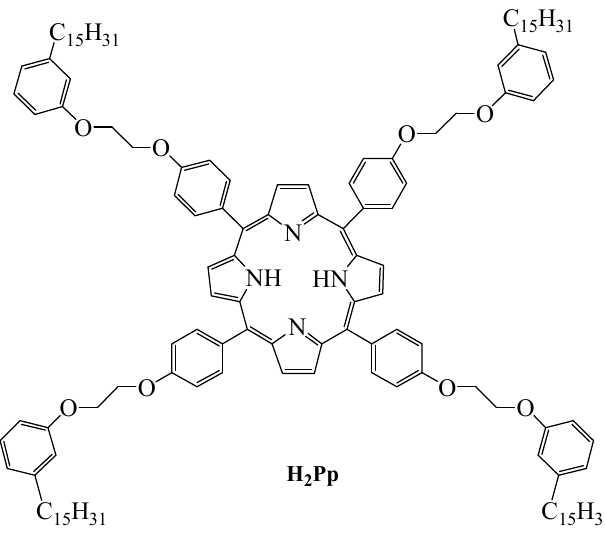
Figure 2. Structure of the lipophilic porphyrin-cardanol derivative (H